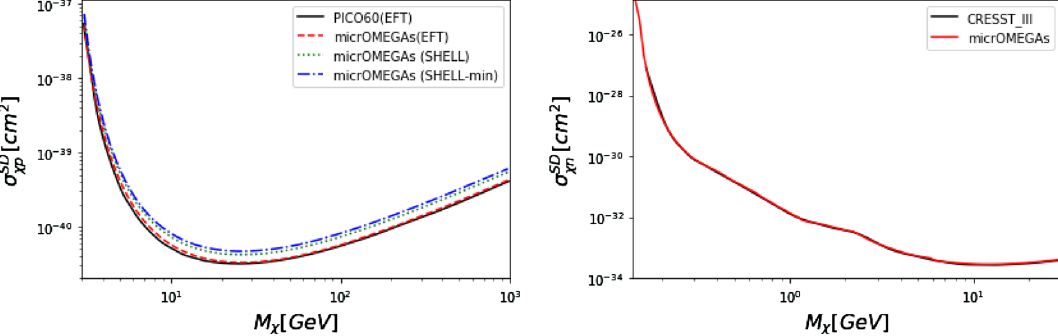
form factors (blue-dot-dash). Right: comparison of the recasted 90% limit on σ SD χ n from micrOMEGAs (red) with the CRESST-III limit [47] (black) with zero momentum form